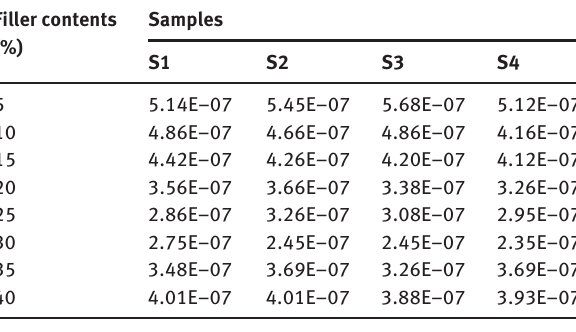
Figure 7: Specific wear rates of the treated CNS filler epoxy compos- ites with various filler